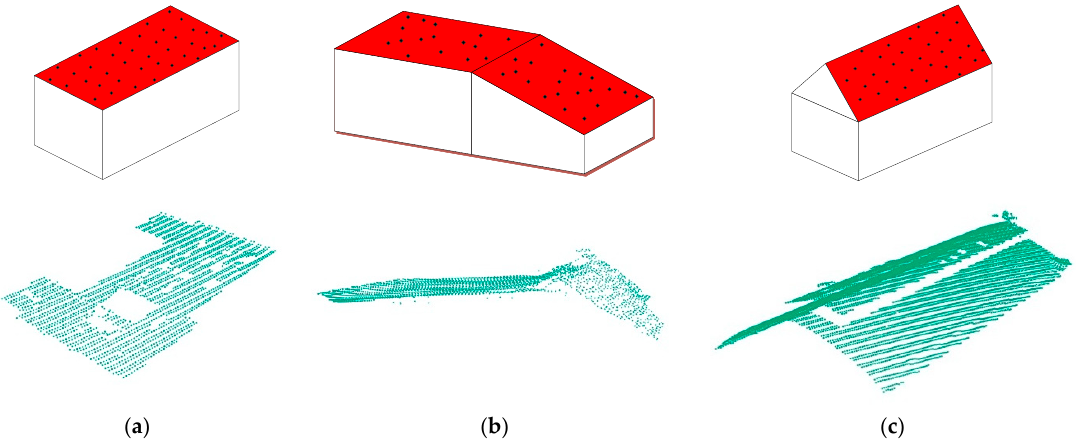
Figure 5. Typical roof types adopted in this paper. ( a ) Type-1: flat roof; ( b ) Type-2: slope roof; and ( c ) Type-3: gabled roof.